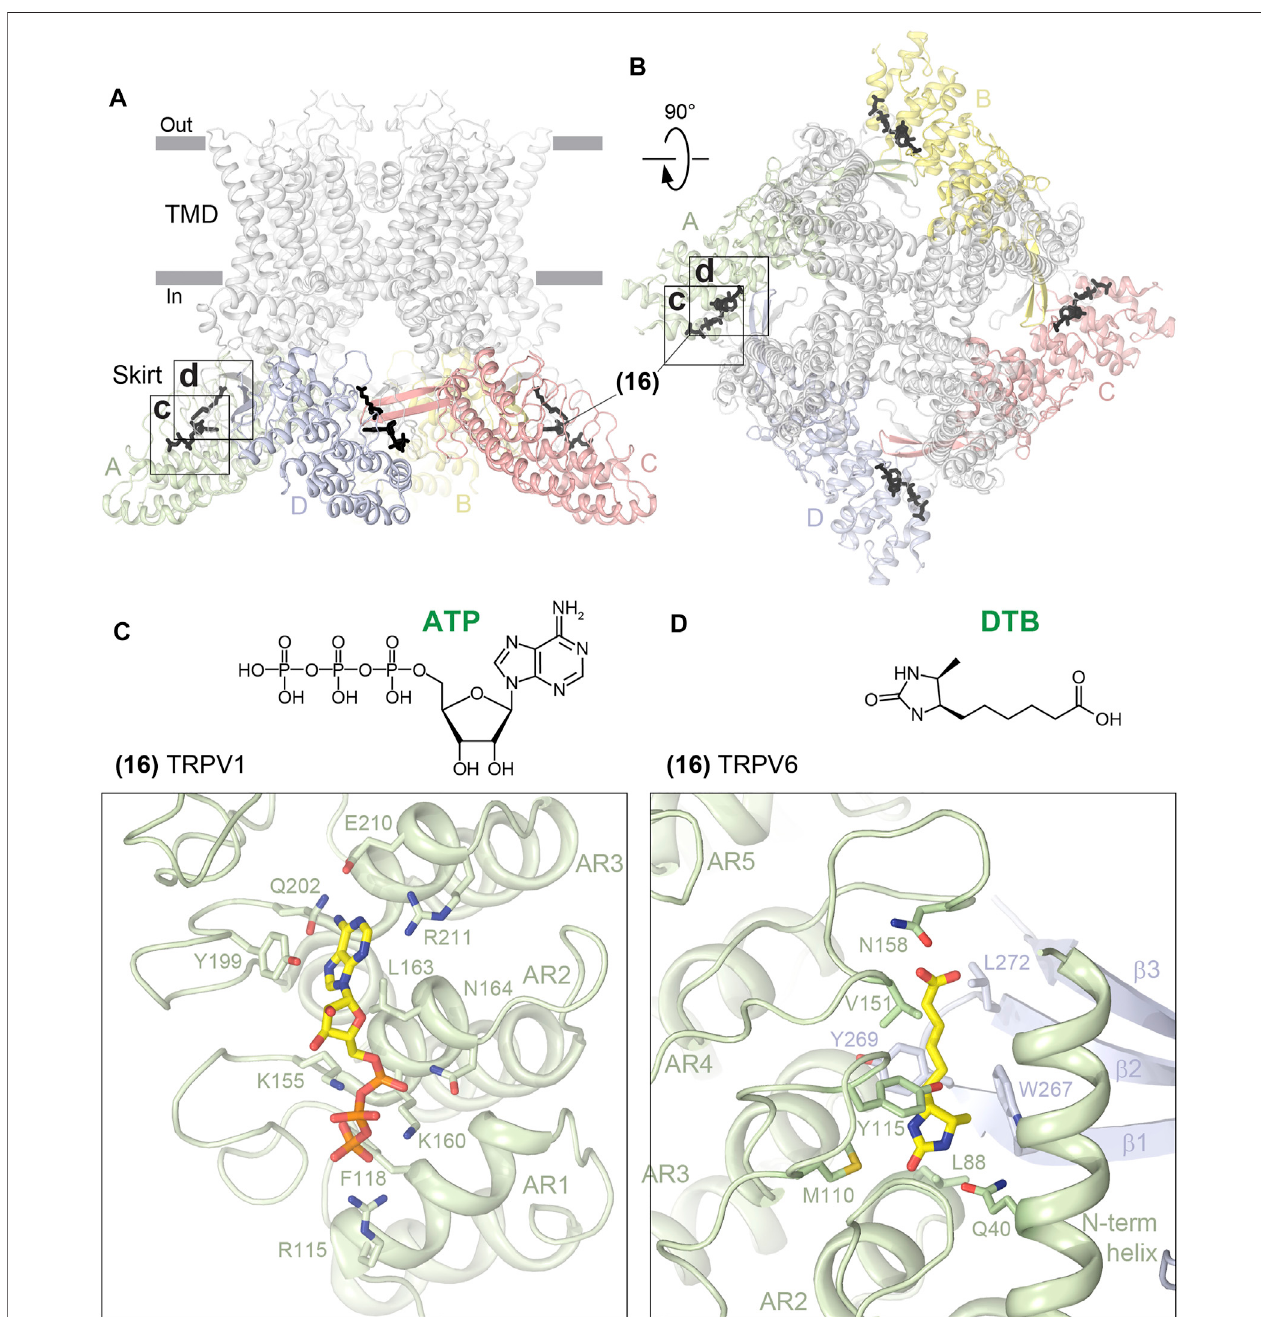
FIGURE 8 | ARD site. Side (A) and top (B) views of the TRPV1 tetramer (gray; PDB ID: 7LQY) with the ARD site (16) illustrated by ligands in black. Rectangles indicate the regions expanded in close-up views. (C – D) Close-up views of the ARD site in TRPV1 with bound ATP ( C , PDB ID: 2PNN) and in TRPV6 with bound desthiobiotin ( D , PDB ID: 5WO9). Residues contributing to ligand binding are shown in sticks. The chemical structures of the ligands are shown above the close- up views.